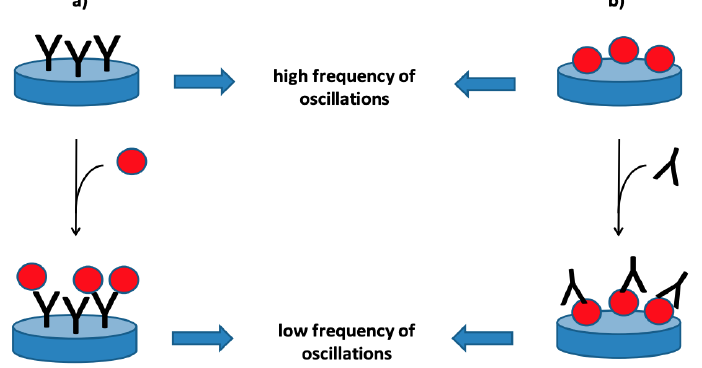
Figure 9: Principle of piezoelectric immunosensors